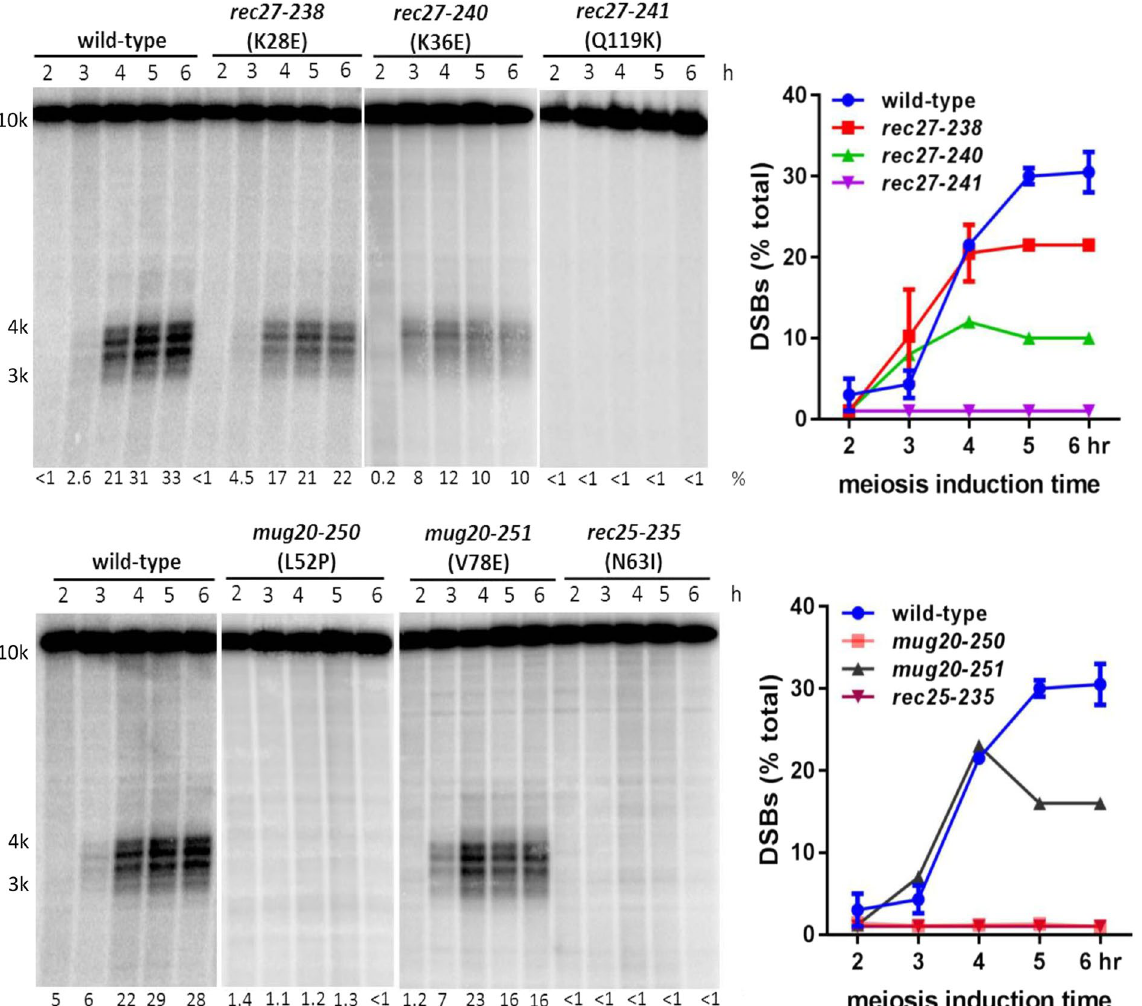
Figure 4. Meiotic DSBs of LinE mutants. LinE mutants were meiotically induced; DNA was extracted at the indicated times, digested with Bsr G1 and analyzed for DSBs at the ade6-3049 hotspot by Southern blot hybridization. Unbroken DNA (10.1 kb) migrates at the top of the blots. Meiotically broken DNA (3–4 kb) migrates as multiple bands near the middle of the blots. The percentage of total radioactivity in the DSB position was quantified with ImageQuant and is shown below each lane and in the graph on the right. Data are individual values or (for wild-type and rec27-238 cells) the range for two independent experiments. Full-length blots are presented in Suppl. Figure